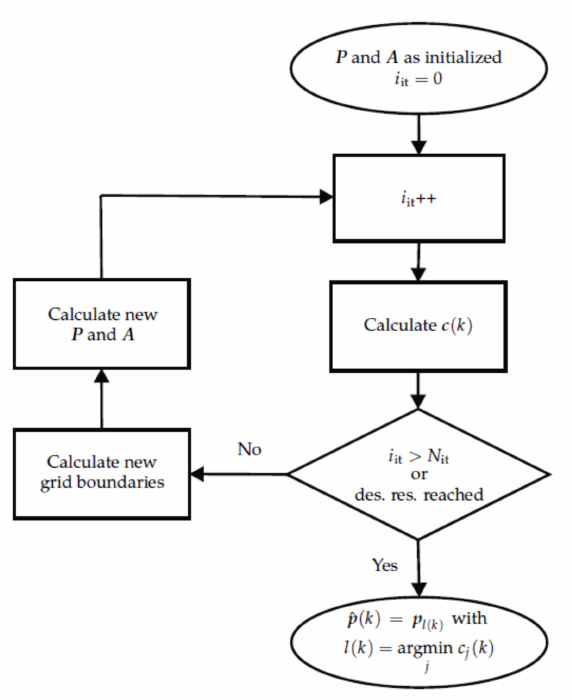
Figure 7. Flow chart of the iterative localization approach for one time step k . As long as neither the maximum number of iterations nor the desired resolution is reached, the algorithm keeps refining the localization